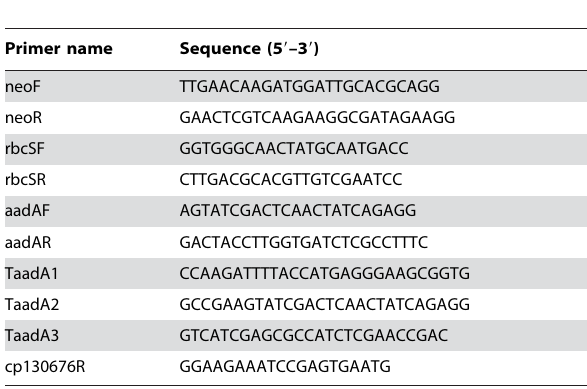
Table 3. Primers used in this